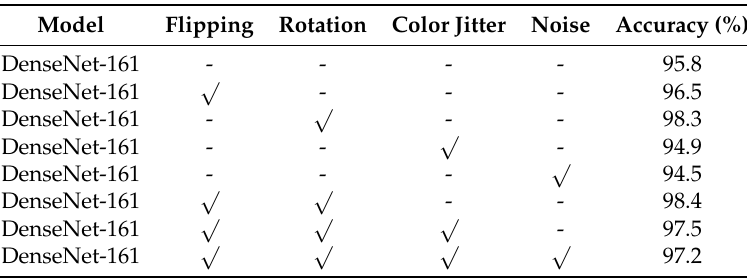
Table 5. Ablation study of augmentation